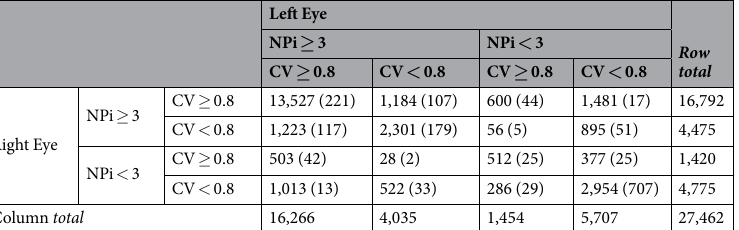
Table 1. Paired observations for left and right eye NPi and CV readings. * Values represent observations and (subjects) with at least one